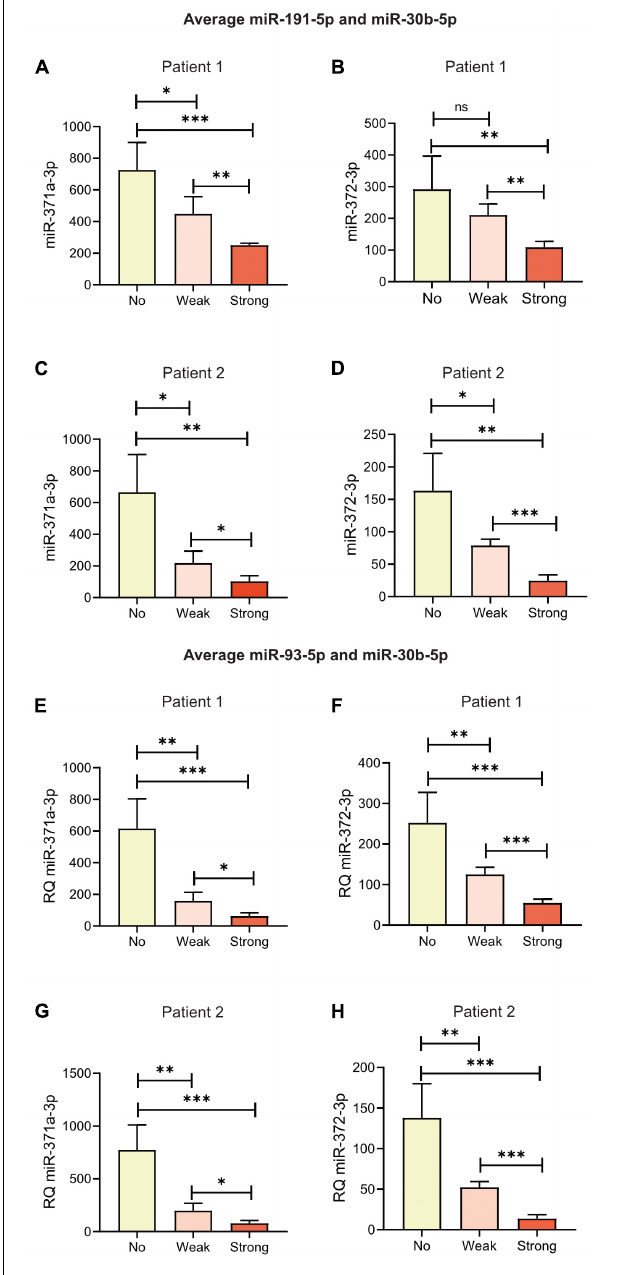
FIGURE 4 | Hemolysis affected the measured levels of specific microRNAs in serum from the two patients. Relative quantities (RQs) representing miR-371a-3p and miR-372-3p in Patient 1 and Patient 2 were calculated with the average of miR-191-5p and miR-30b-5p (A–D) or the average of miR-30b-5p and miR-93-5p (E–H) as reference genes. “No,” “Weak,” and “Strong” represent the same serum, but with 0.0, 0.05, or 0.2% added RBCs, respectively. ∗ P < 0.05, ∗∗ P < 0.01, ∗∗∗ P < 0.001. Bars represent mean RQ with standard deviations (SD). RQ = 2 − (cid:49)(cid:49) Cq